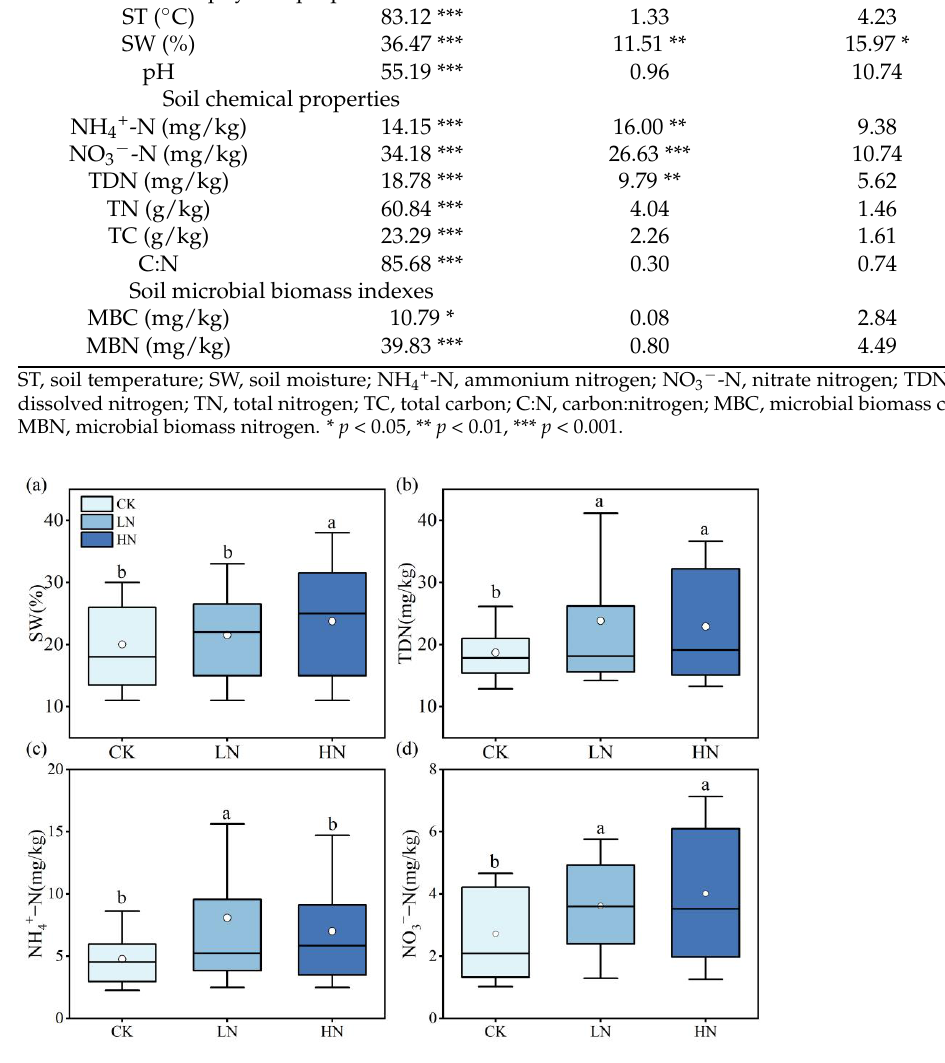
Figure 5. Responses of soil moisture (SW, a ), total dissolved nitrogen (TDN, b ), ammonium nitrogen (NH 4+ -N, c ), and ammonium nitrogen (NO 3 − -N, d ) to nitrogen application rates during the study period. Error bars represent 10th and 90th percentiles. Black lines and white dots within the boxplots indicate median and mean values, respectively. Different letters on top of the error bars denote significant differences among nitrogen application rates at the 0.05 level. CK, LN, and HN represent control, low, and high nitrogen applications, respectively.